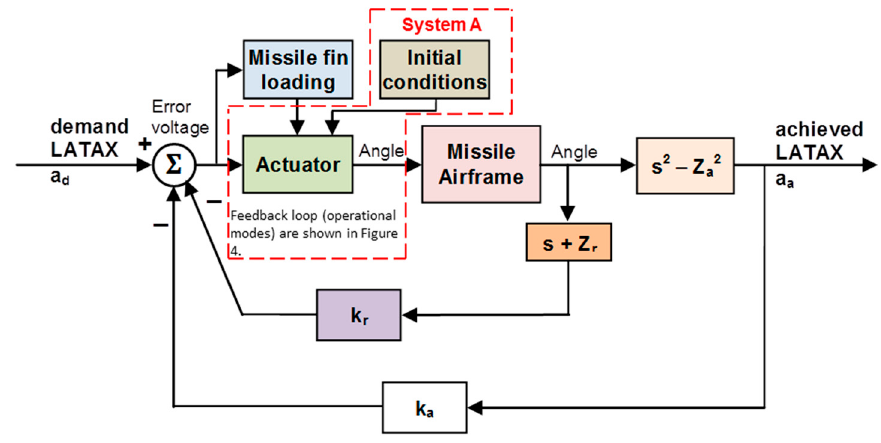
Figure 3. Missile LATAX autopilot (Level 2).